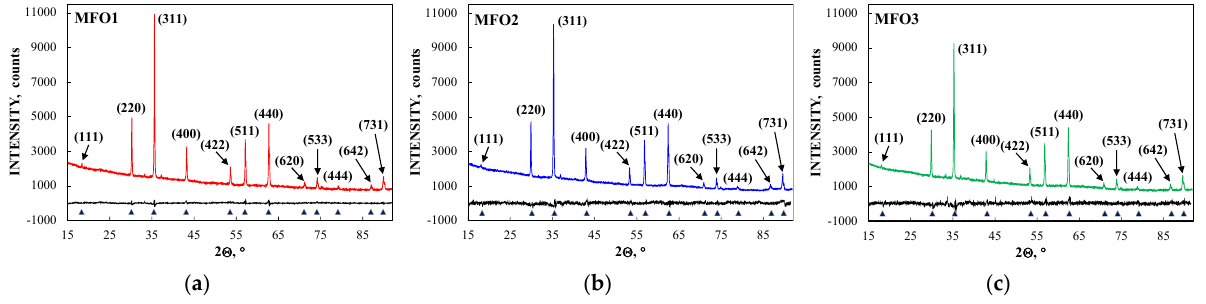
Figure 67. XRD patterns of MgFe 2 O 4 nanoparticles in samples MFO1 ( a ), MFO2 ( b ) and MFO3 ( c ). Miller’s indices and results of Rietveld refinement of MgFe 2 O 4 structure for the MFO1, MFO2 and MFO3 samples are shown. The differences between measured and calculated profiles are shown below the XRD patterns. Symbols ▲ indicate the positions of diffraction maxima in MgFe 2 O 4 structure from ICDD card No. 01‑088‑1935. Adapted from Ref. [94] with permission from Elsevier: Journal of Alloys and Compounds, Vol. 912, Ushakov M.V., Nithya V.D., Rajeesh Kumar N., Arunkumar S., The crystallite size calculated from XRD patterns using the Scherrer formula decreases with an increase in fuel concentration: 110 nm (MFO1), 95 nm (MFO2) and 75 nm (MFO3). Isothermal magnetization curves also demonstrate some differences for these three sam‑ ples as shown in Figure 68. The results of magnetization measurements indicated that the values of coercivity decreased while remanent magnetization values increased continuously with increasing the fuel amount and decreasing the crystallite size.